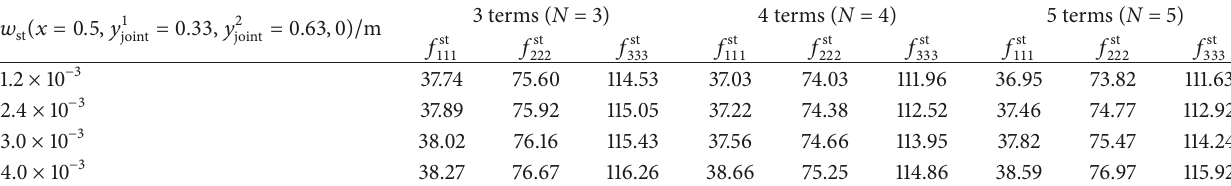
Table 1: The first three frequencies with different amplitudes